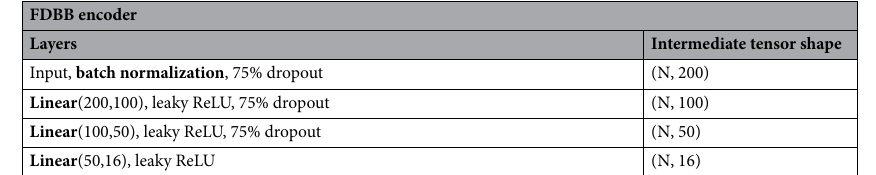
Table 2. Frequency domain black box (FDBB) encoder network parameters. The fully connected subnetwork was designed to learn how to derive relationships between the power densities of each frequency band. N is the batch number of the input tensor. Trainable layers are given in bold.